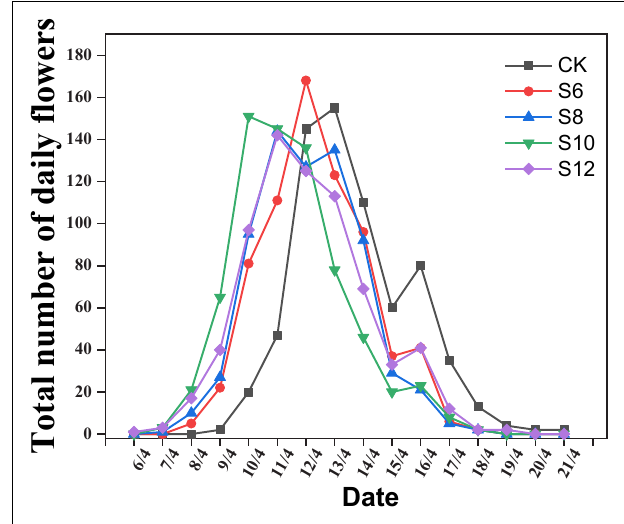
FIGURE 1 | Effect of different supplemental blue light frequencies on flowering of tomato. The data representing the total number of daily flowers in all the plants ( n = 60) for each